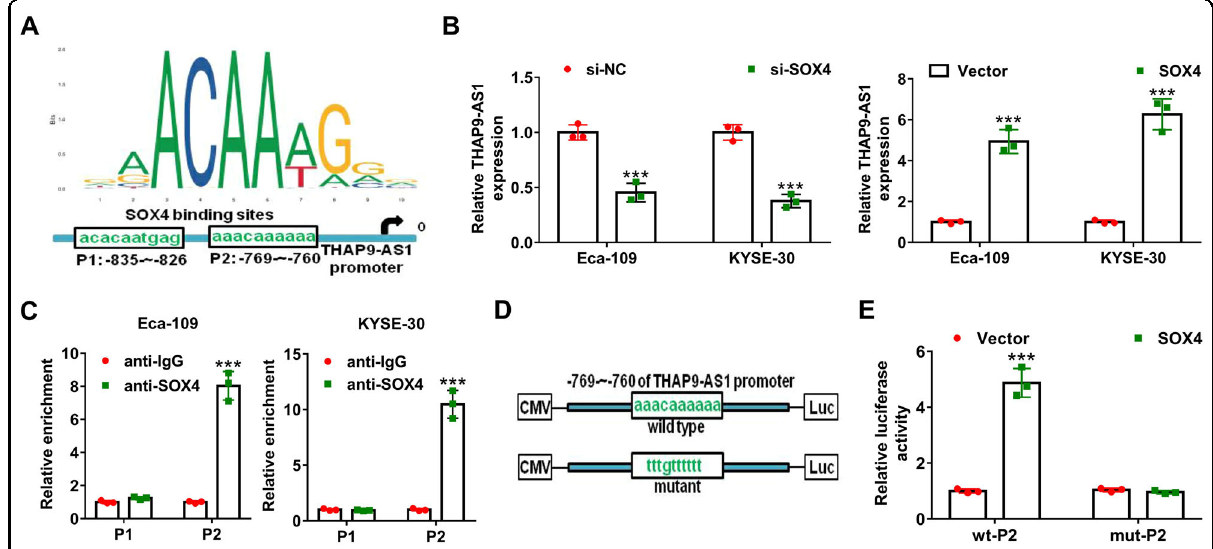
Fig. 7 SOX4 transcriptionally activates THAP9-AS1 in ESCC cells. A JASPAR (http://jaspar.genereg.net/) was used to predict the binding sites of transcription factor SOX4 on THAP9-AS1 promoter region. B qRT-PCR assays were used to detect the expression of THAP9-AS1 in Eca-109 and KYSE- 30 cells with SOX4 knockdown or overexpression. C ChIP assay was applied to detect the binding af fi nity of SOX4 with THAP9-AS1 promoter at the two predicted sites (P1 and P2) by using antibodies against SOX4 or IgG. D Regarding the P2 binding sites ( − 769 ∼ − 760) of SOX4 on the THAP9-AS1 promoter, wild-type, and mutant luciferase vectors was constructed accordingly. E Dual-luciferase reporter assays were performed in HEK-293T after transfection with wt-P2 or mut-P2 and vector or pcDNA-SOX4. *** P <